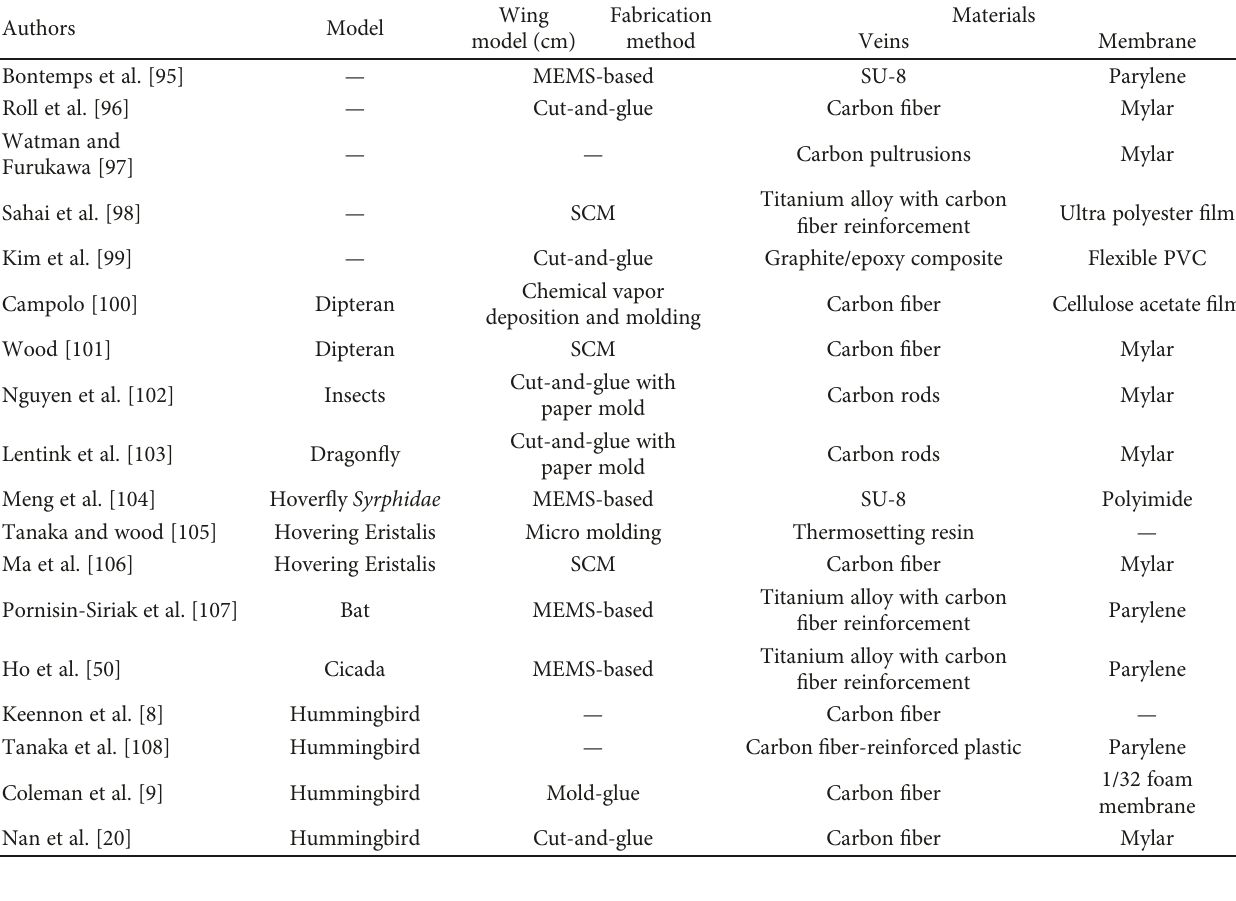
Table 5: Arti fi cial wings, including fabrication materials and